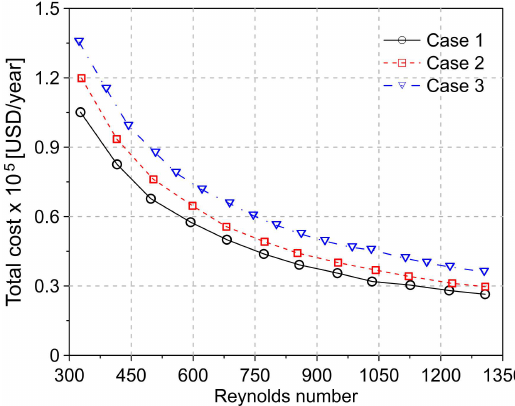
Figure 24. Total cost of PCHE vs. Reynolds number.